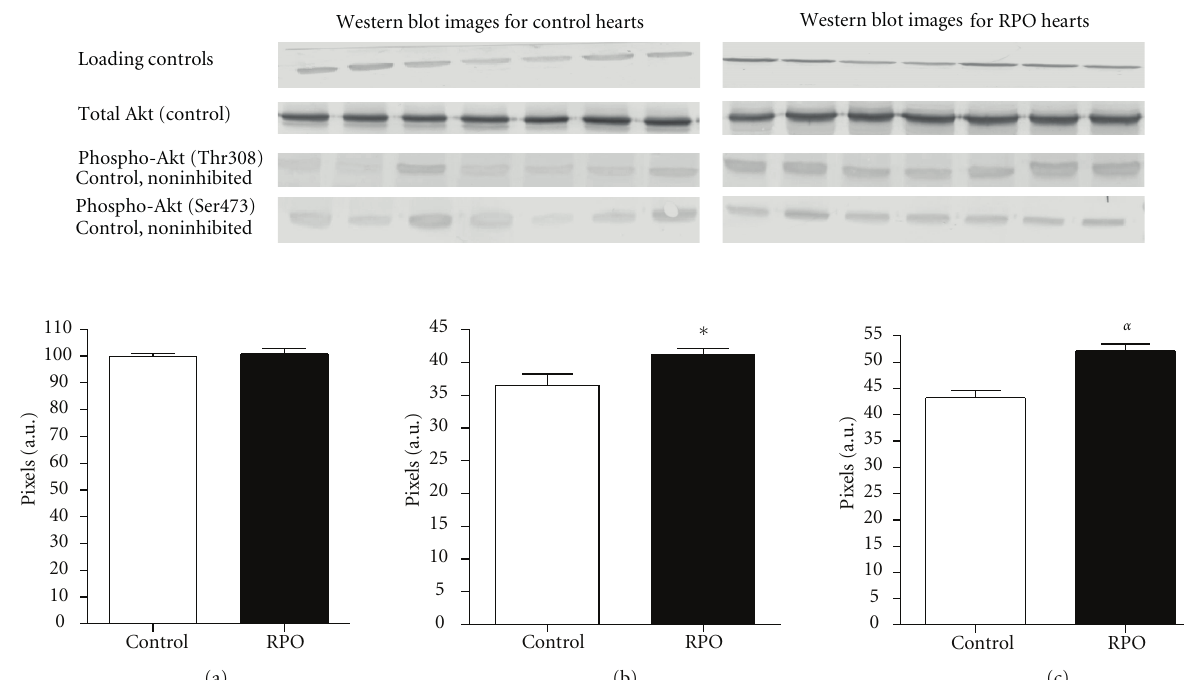
Figure 3: (a) The e ff ect of RPO on total Akt during reperfusion. (b) The e ff ect of RPO on phospho-Akt (Ser473) during reperfusion. (c) The e ff ect of RPO on phospho-Akt (Thr308) during reperfusion.